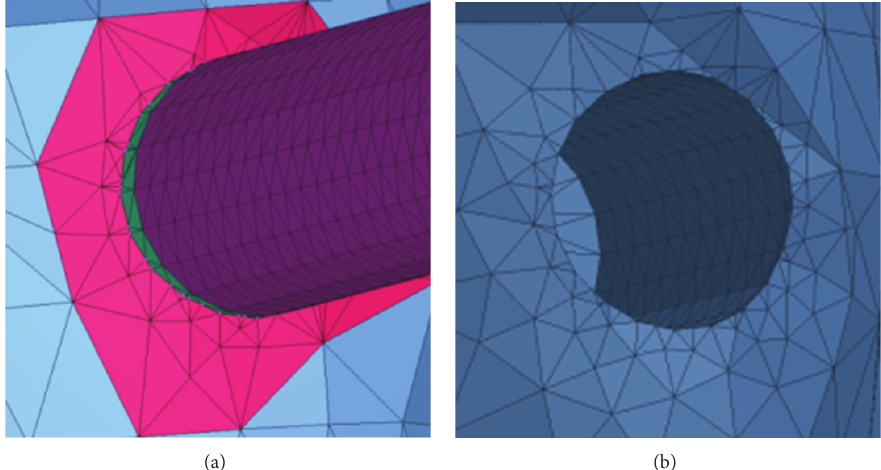
Figure 12: Inserting implant. (a) Remeshed intersection model according to the intersection curve. (b) Hole model based on implant shape for automatic intersection.